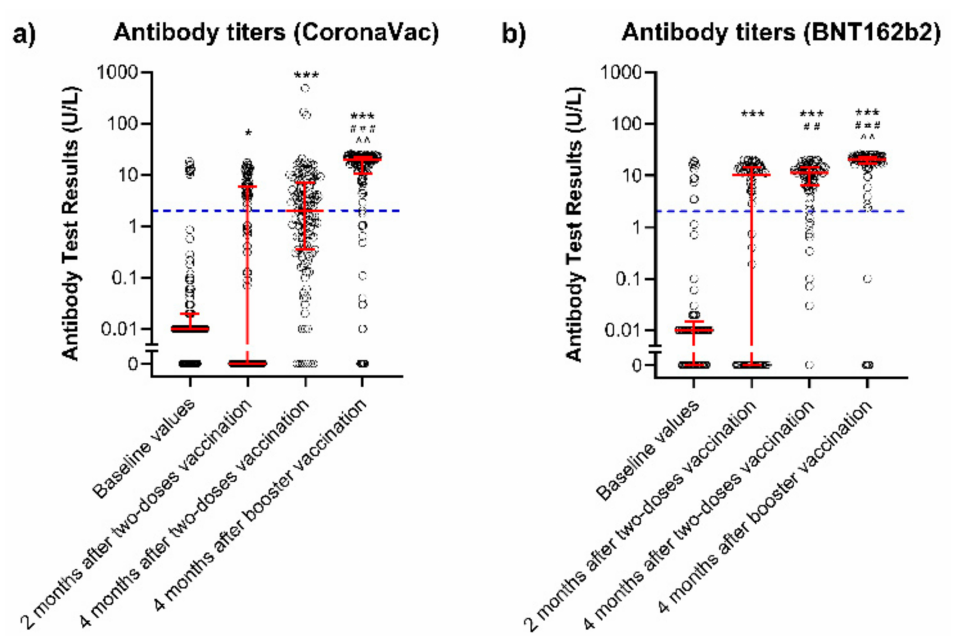
Figure 1. Humoral immune response before and after two vaccine doses and booster doses in end-stage renal disease patients in hemodialysis. Individual patient data of antibody titers before vaccination (baseline values), 2 and 4 months after a two-dose vaccination schedule, and 4 months after a booster dose (scatter dot plot). All patients received the BNT162b2 vaccination as the booster dose, regardless of the previous vaccination ( a ) Patients who received the CoronaVac vaccine and ( b ) patients who received the BNT162b2 vaccine. Blue dotted lines indicate vaccine responsiveness cutoffs (2 U/L). Red lines express median (percentile 25–percentile 75). *** p < 0.001, * p < 0.05 vs. baseline. ### p < 0.001, ## p < 0.01 vs. 2 months. ˆˆ p < 0.01 vs. 4